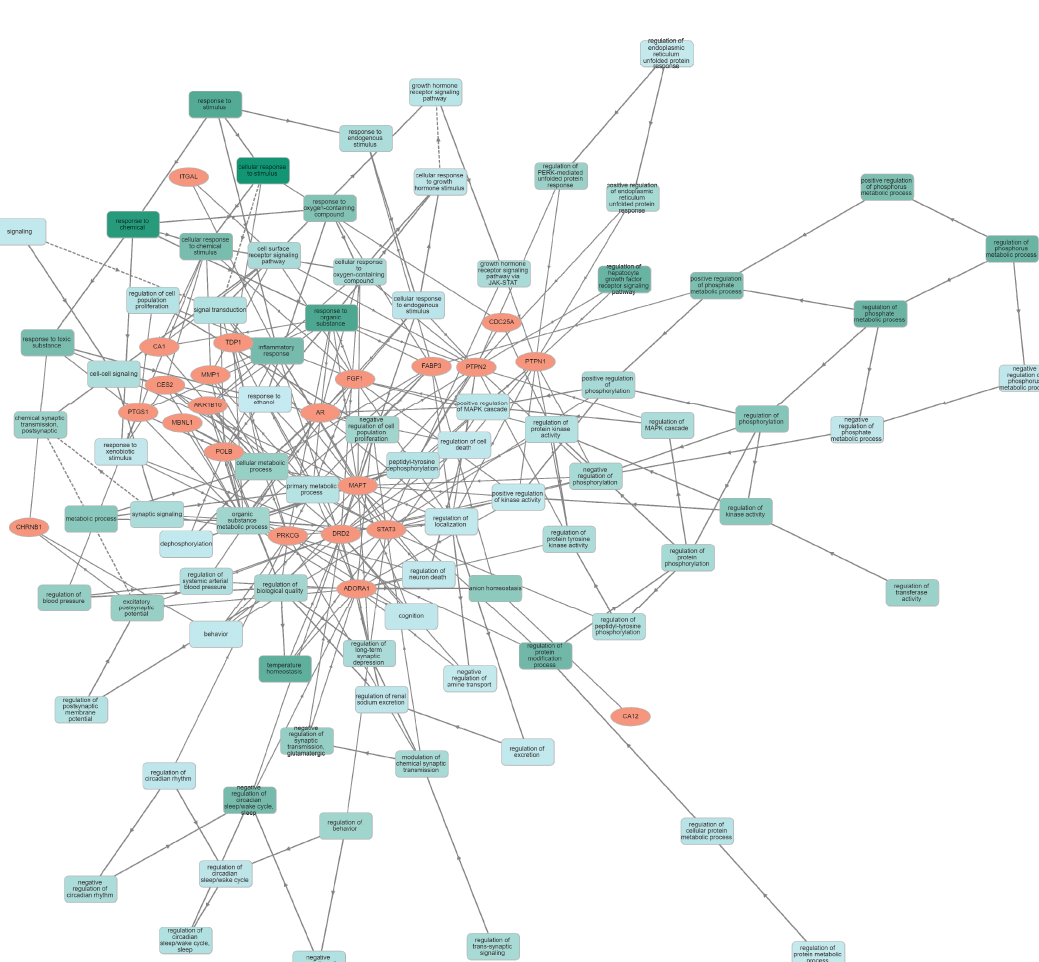
Figure 2 : Classification human targets with their biological processes. Orange color encodes human targets; green color represents biological processes.